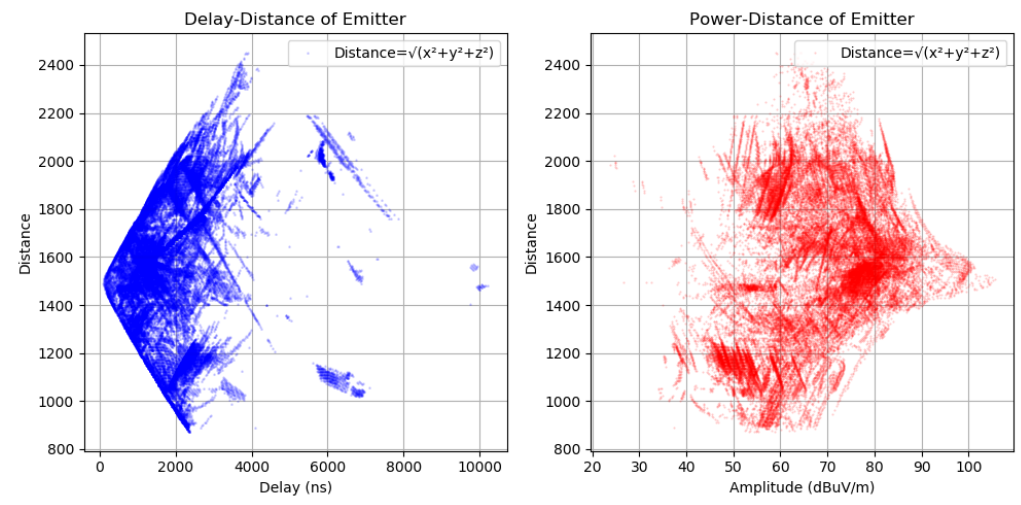
Figure 22. Testing the dataset with delay–distance and power–distance